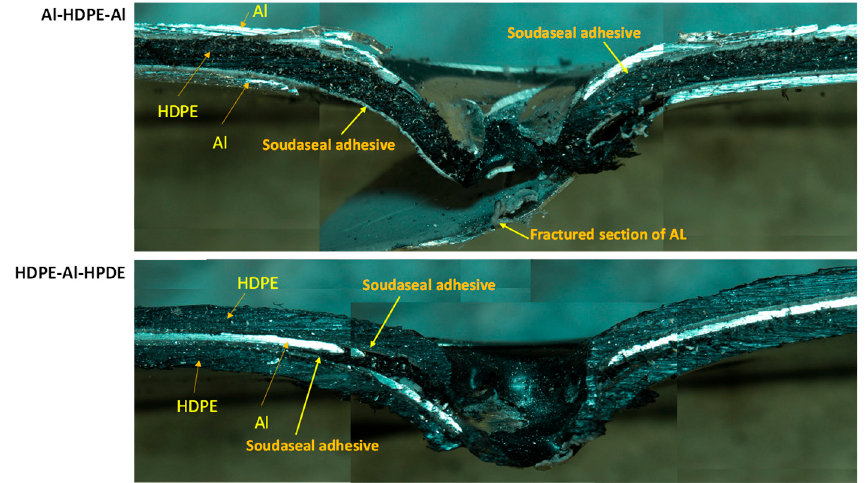
Figure 14. Cross-sectional view of the failure modes of tri-layer laminates under the conical in- denter.